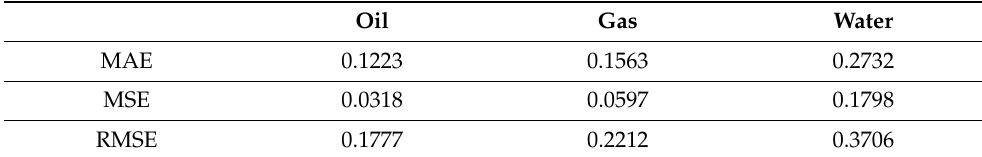
Table 3. Other evaluation measures on the ANN model.